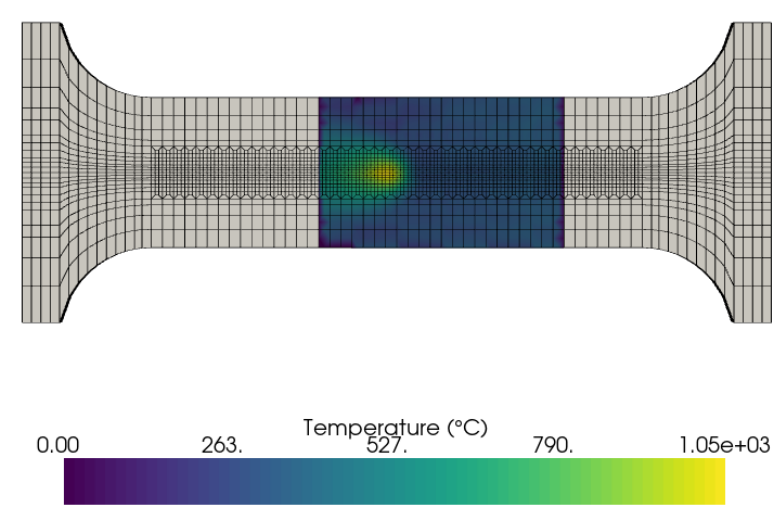
Figure 4. Projection of infrared images on the FE mesh.